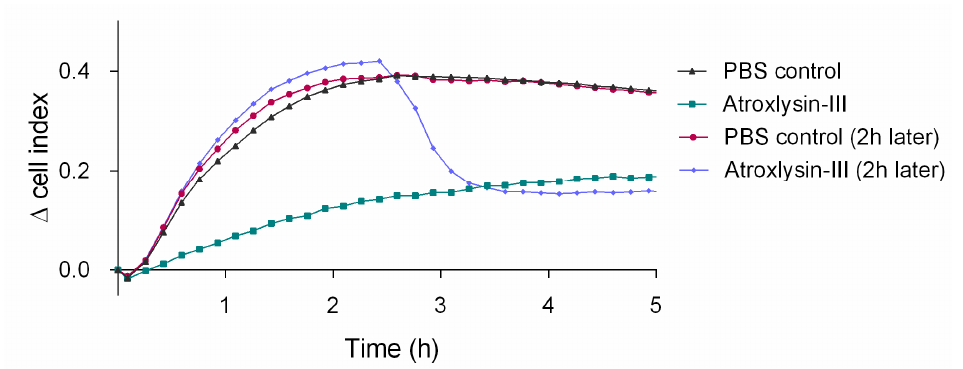
Figure 10. Platelet attachment to collagen-I-coated surface with concomitant and delayed (2 h) addition of Atr-III. The adhesion of platelets to collagen I was monitored by real-time impedance measurement in the xCELLigence system, on E-plates coated with 5 µ g / mL of collagen I. Platelets treated with 32 µ g / mL of Atr-III show a decreased adhesion, in both treatment regimens, at time 0 and 2 h after. The impedance values are corrected for the background values to obtain the real-time ∆ cell index values. This data is representative of three independent experiments performed in duplicates.